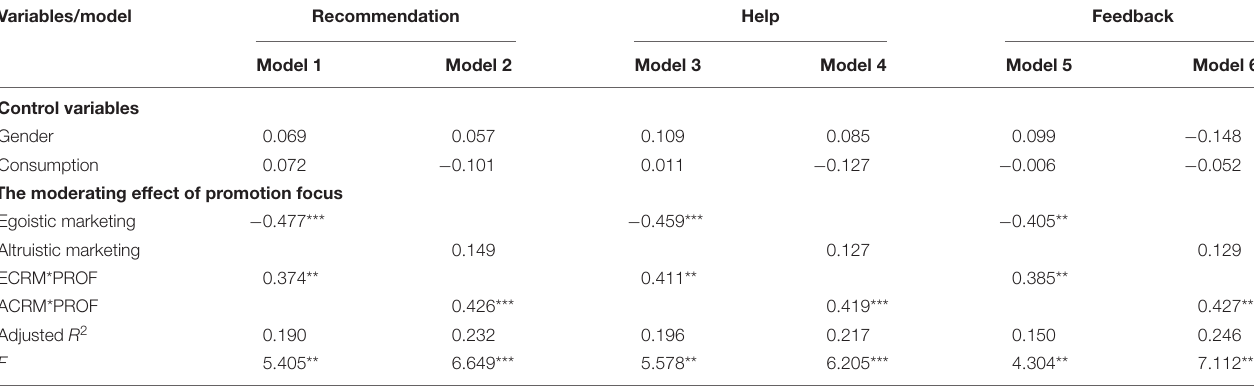
TABLE 3 | Test results of the moderating effect of promotion focus.